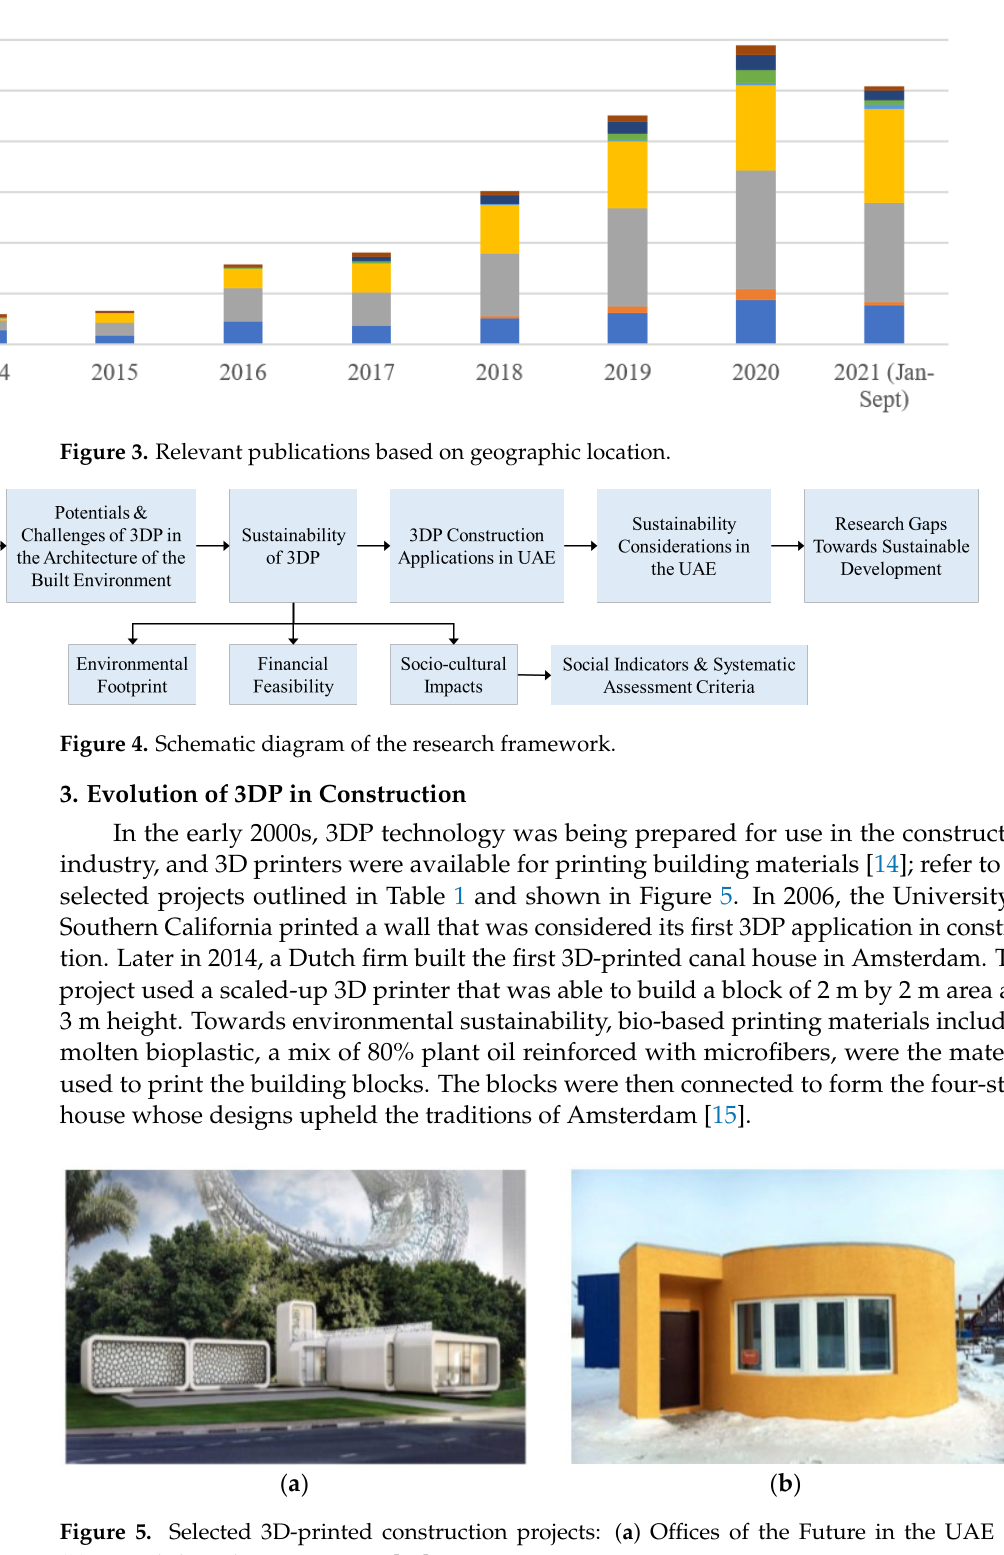
Figure 5. Selected 3D-printed construction projects: ( a ) Offices of the Future in the UAE and ( b ) curved shape house in Russia [19].